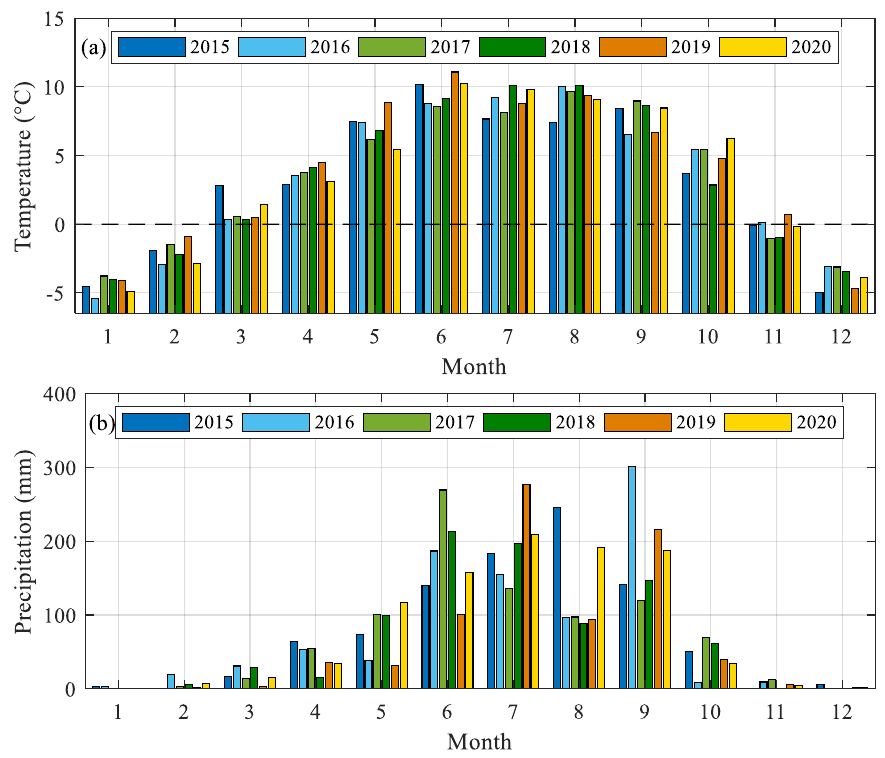
Figure 11. ( a , b ) show the comparison of monthly mean temperature and cumulative precipitation from 2015 to 2020,